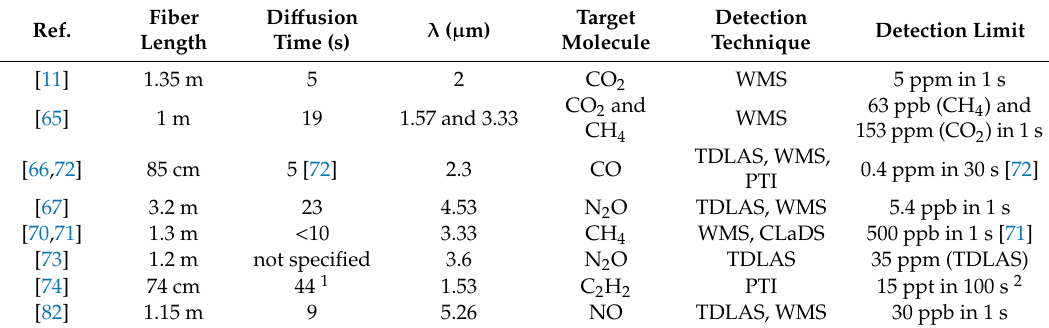
Table 3. Summary of the performance of gas sensing with NC HCFs reported in the literature. Ref.